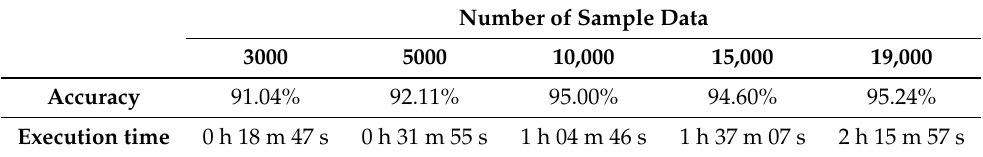
Table 5. Specific port failure diagnosis results for array antenna by number of sample